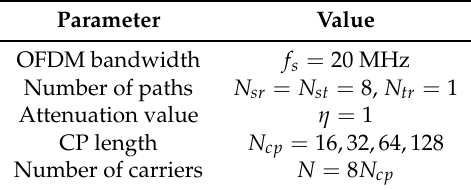
Table 1. Simulation